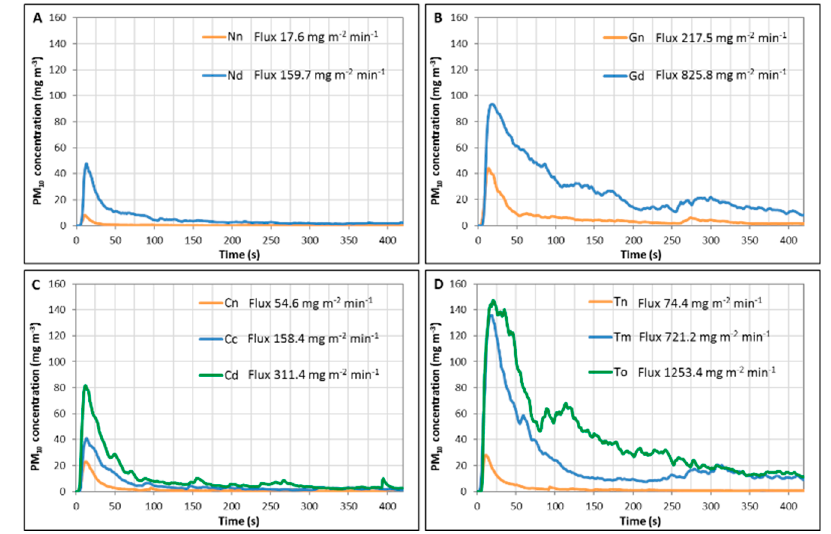
Figure 6. PM10 concentrations measured in the wind tunnel during the experiments in the land use areas: ( A ) Natural soil before (Nn) and after (Nd) artificial (short-term) disturbance. ( B) Grazing area soil before (Gn) and after (Gd) artificial (short-term) disturbance. ( C ) Conventional agriculture practice with no-till (Cn), disk-tillage (Cd), and cultivator-tillage (Cc). ( D ) Traditional practice with no grazing (Tn), medium grazing (Tm), and over-grazing (To). The PM10 fluxes (mg m − 2 min − 1 ) are presented at the upper right corner. (Data were taken from Swet and Katra, 2016 [11], and Tanner et al., 2016 [20]).